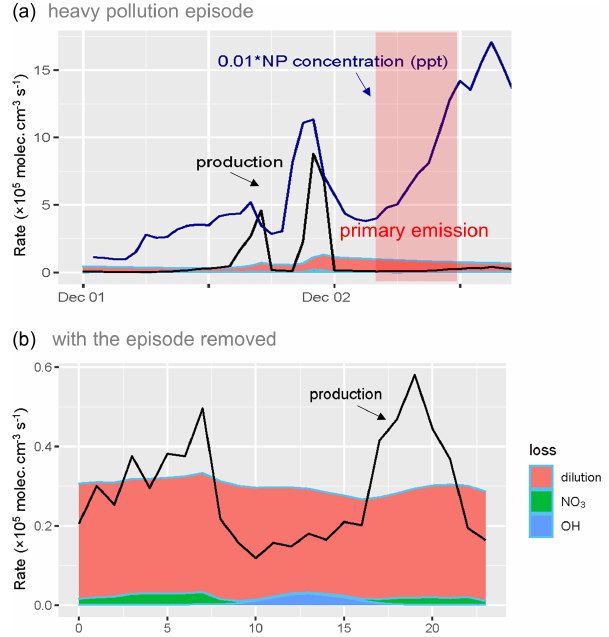
Figure 5. Time series of production and loss of nitrophenol (NP) during the heavy pollution episode (a) and diurnal profiles of pro- duction and loss of NP with the heavy pollution removed (b) .